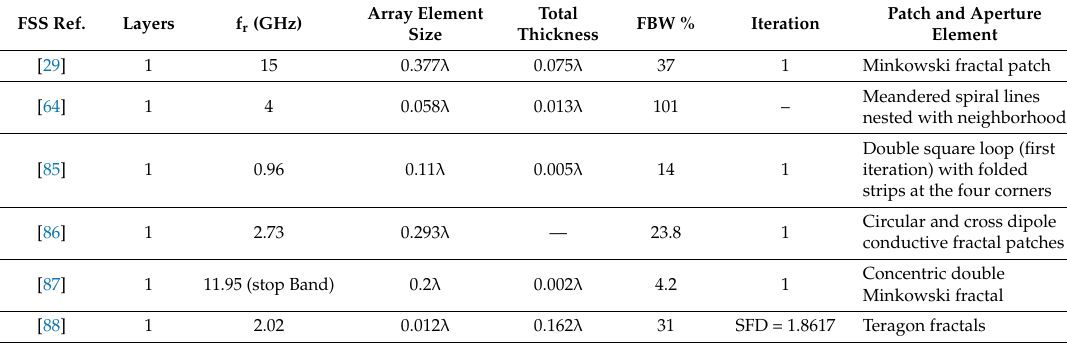
Table 3. Different types of fractal and meandered